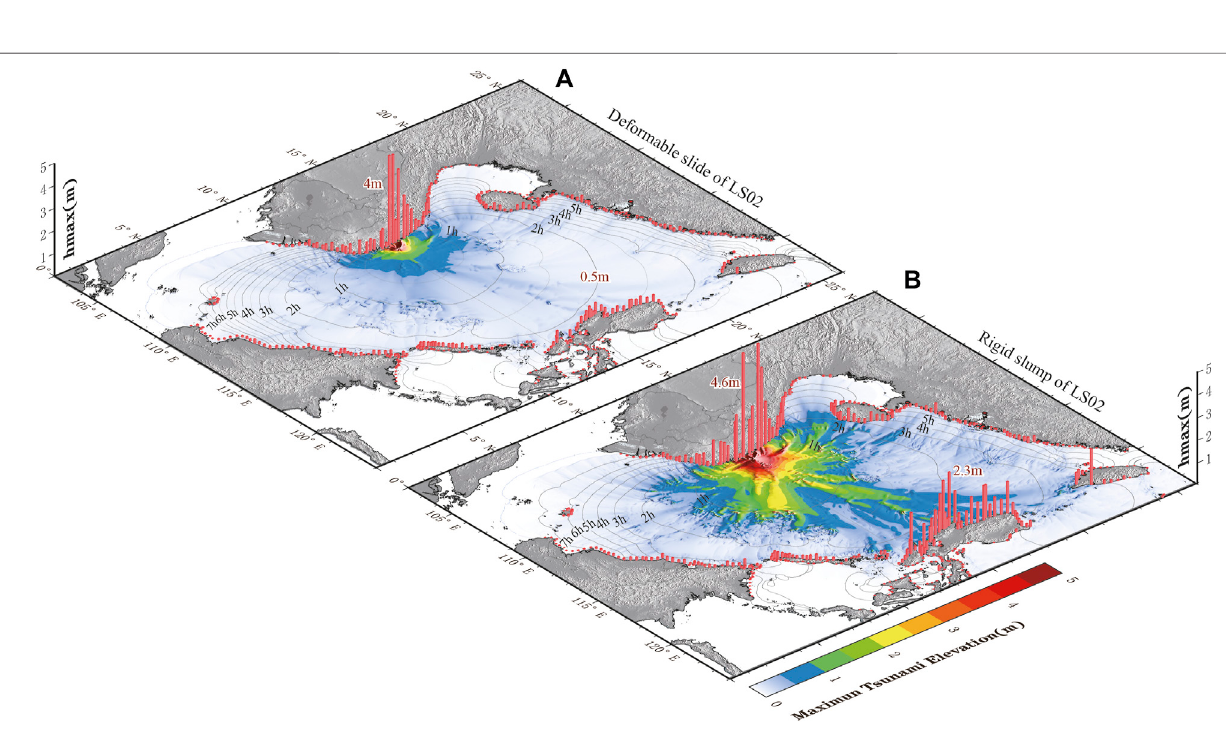
Frontiers in Earth Science |